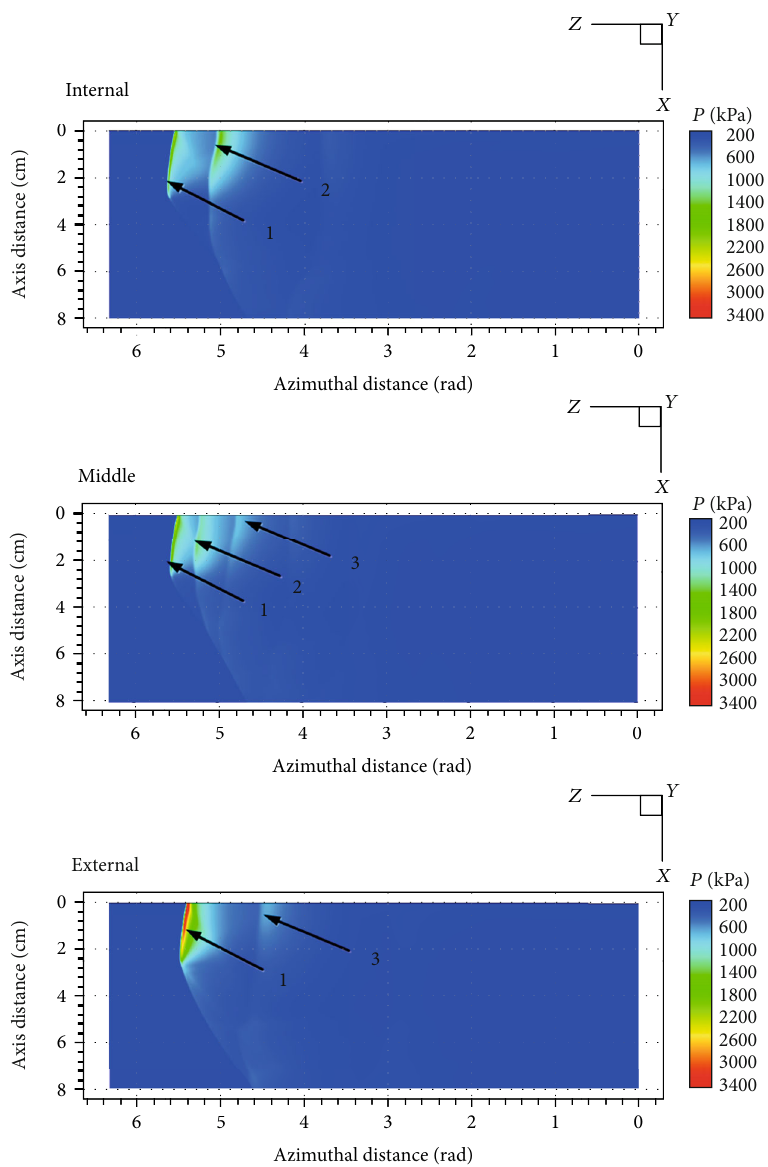
Figure 5: Pressure contours on the inner, middle, and outer radius ( H = 15